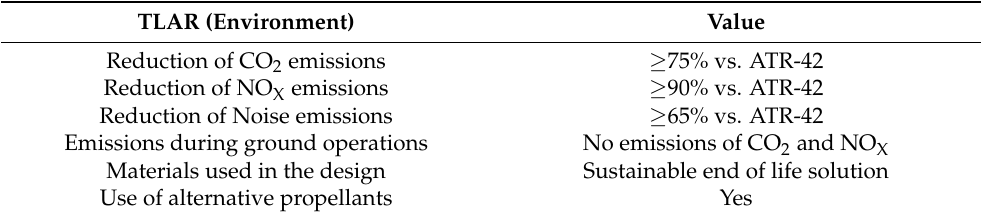
Table 1. Top-level aircraft requirements (TLARs) with regard to environmental